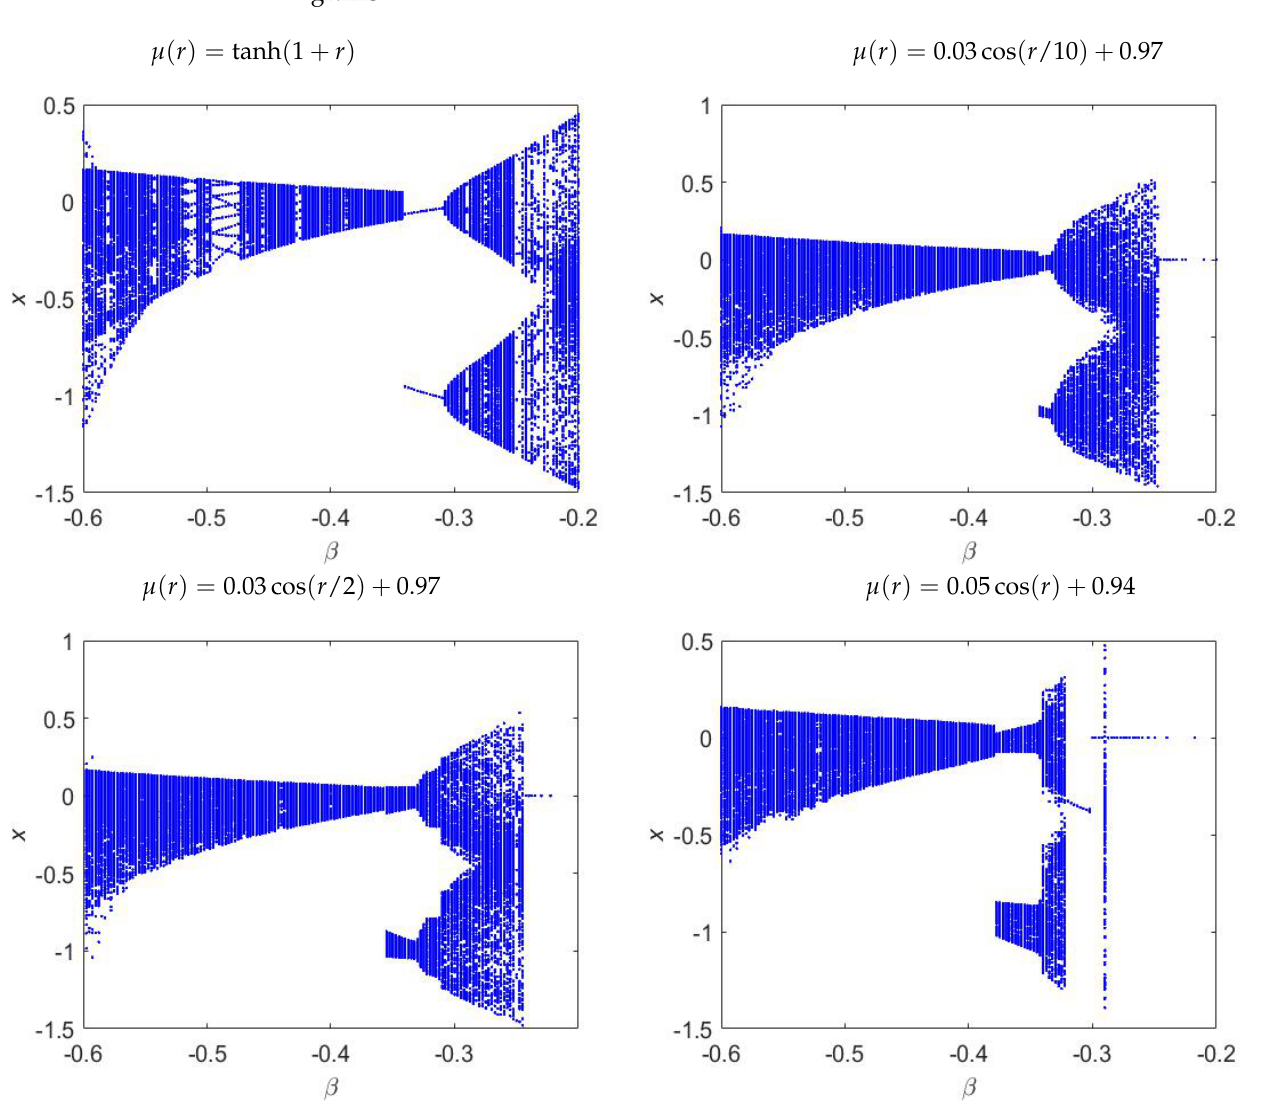
Figure 3. Bifurcation diagrams of the fractional variable-order Tinkerbell map (8) with β ∈ [ − 0.6, − 0.2 ] changed in steps of ∆ β = 0.0025, parameters ( θ , ρ , η ) = ( 0.9,2,0.5 ) , initial condition ( x ( 0 ) , y ( 0 )) = ( − 0.72, − 0.64 ) , and different fractional